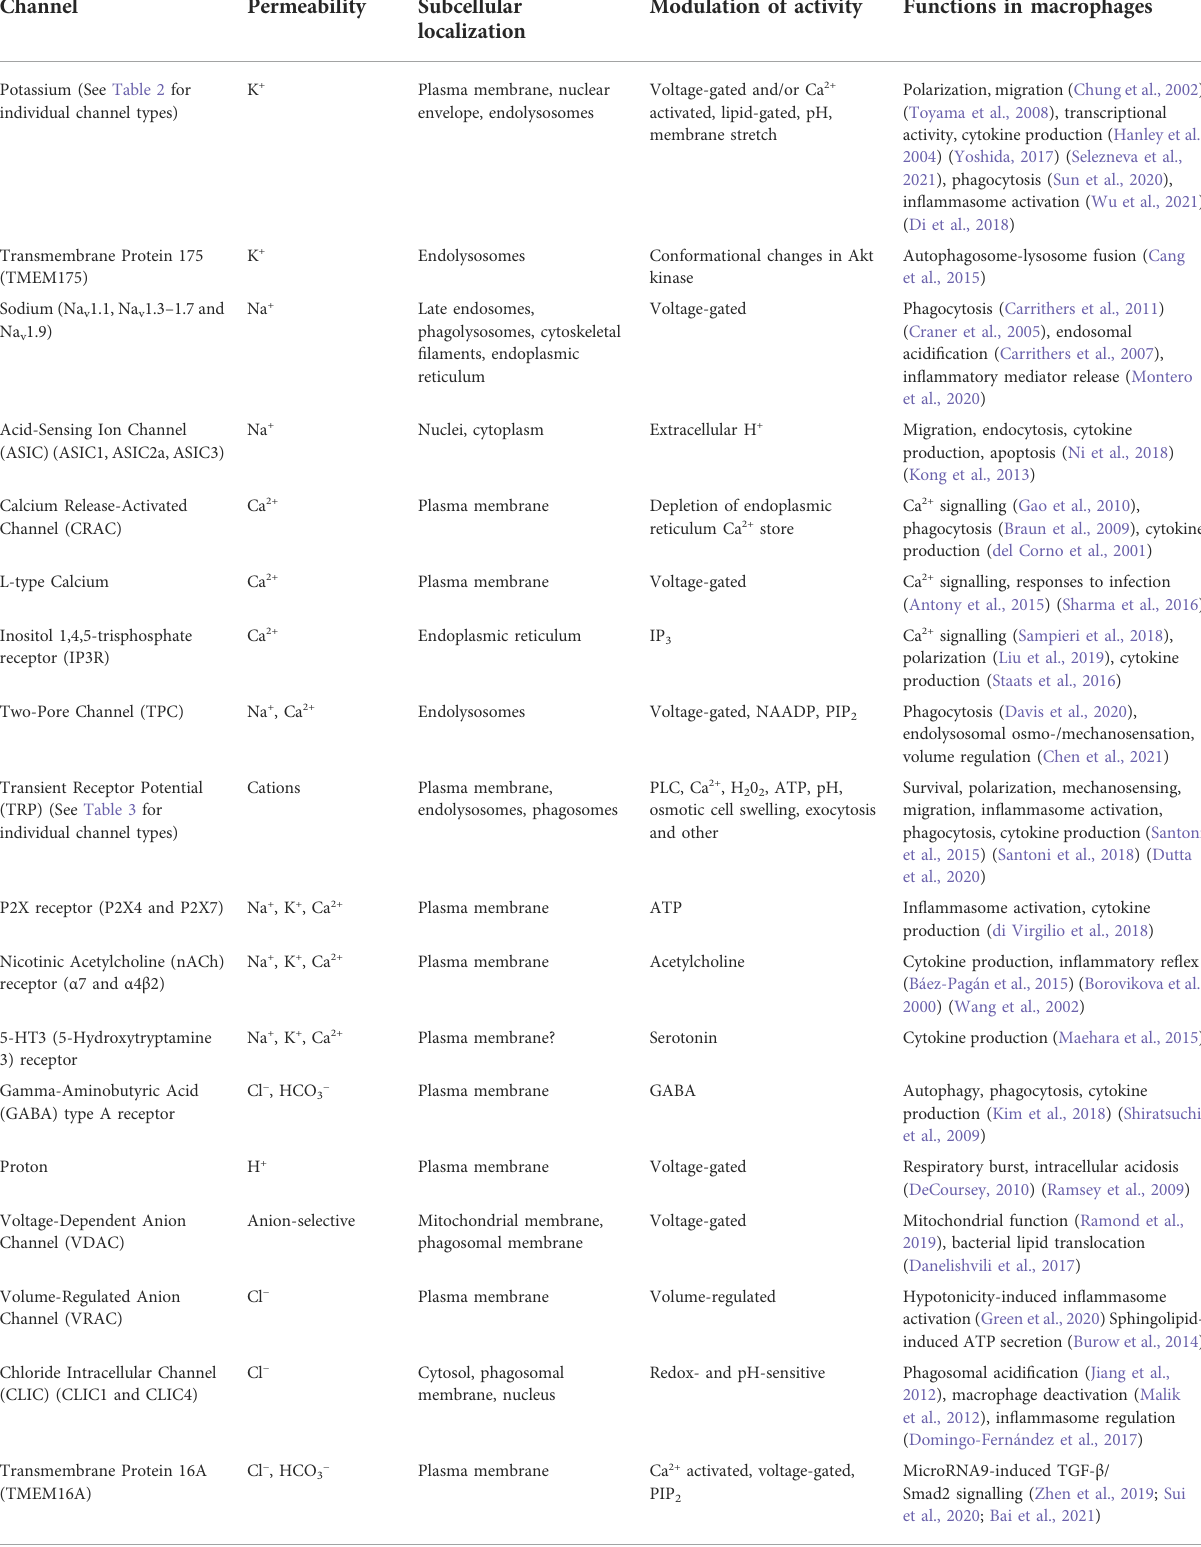
TABLE 1 Currently identi fi ed functional ion channels in